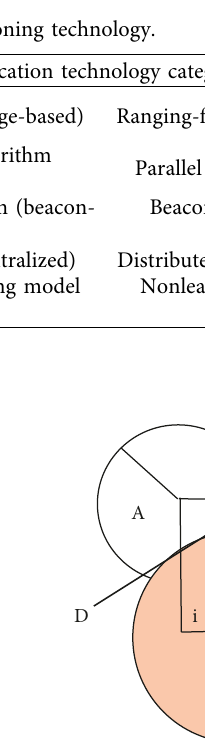
Figure 3: Schematic diagram of trilateral positioning